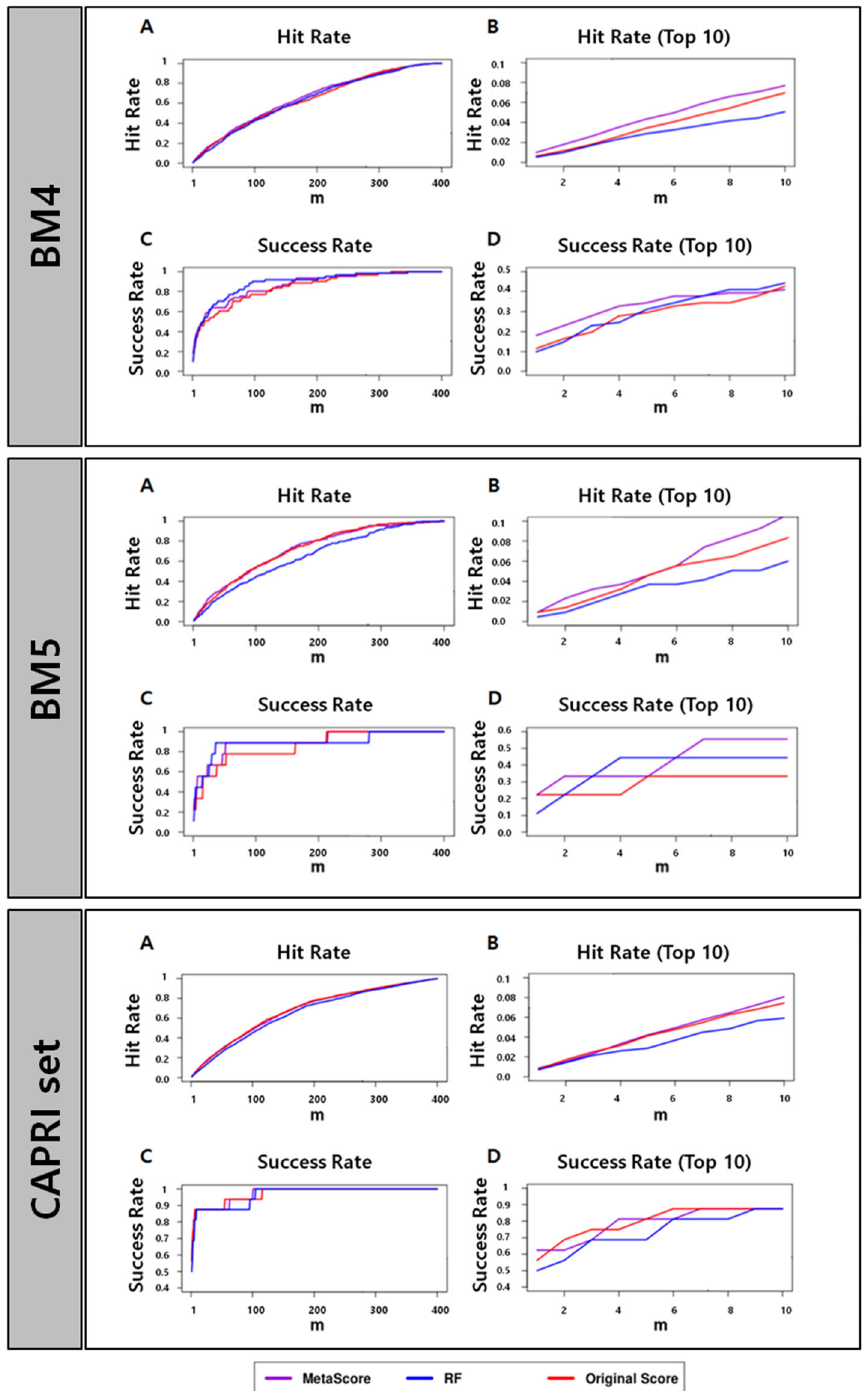
Figure 1. Success rates and hit rates plotted against the top m conformations for a classical scoring method (HADDOCK), machine ‐ learning ‐ based method using RF (RF), and the combined method of the two methods (MetaScore) using the BM4 decoy training set, BM5 decoy set, and CAPRI set (top, middle, and bottom panel, respectively). There are four subpanels for each panel: ( A ) hit rates for conformations of top m ranging from 1 to 400; ( B ) hit rates for conformations of top m ranging from 1 to 10; ( C ) success rates for conformations of top m ranging from 1 to 400; ( D ) success rates for conformations of top m ranging from 1 to 10.